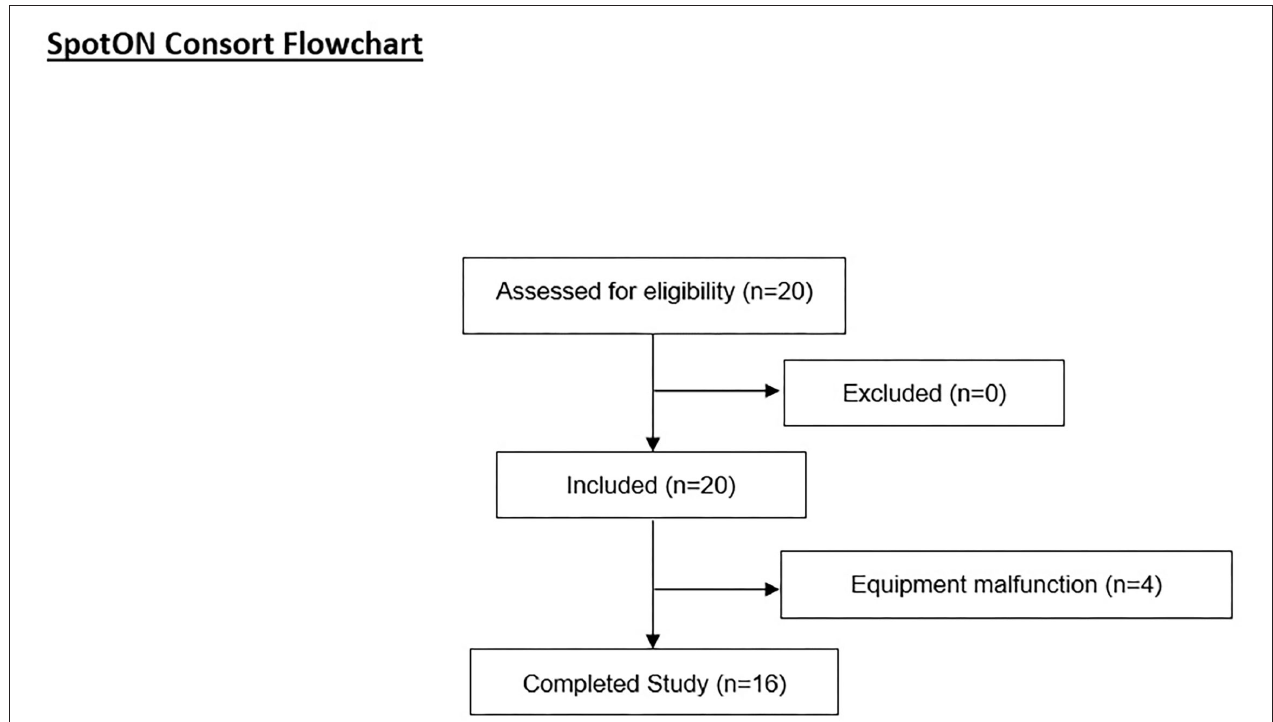
FIGURE 1 | Enrolment flow